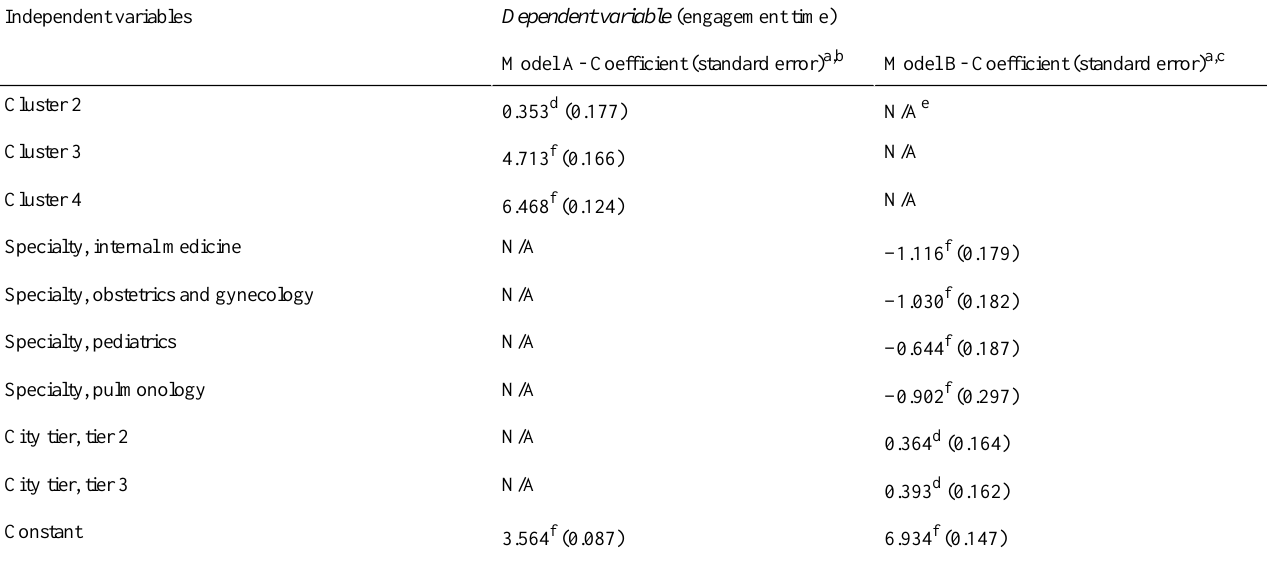
Table 5. Regression results for model A (cluster-based model) and model B (demographic variable–based model).